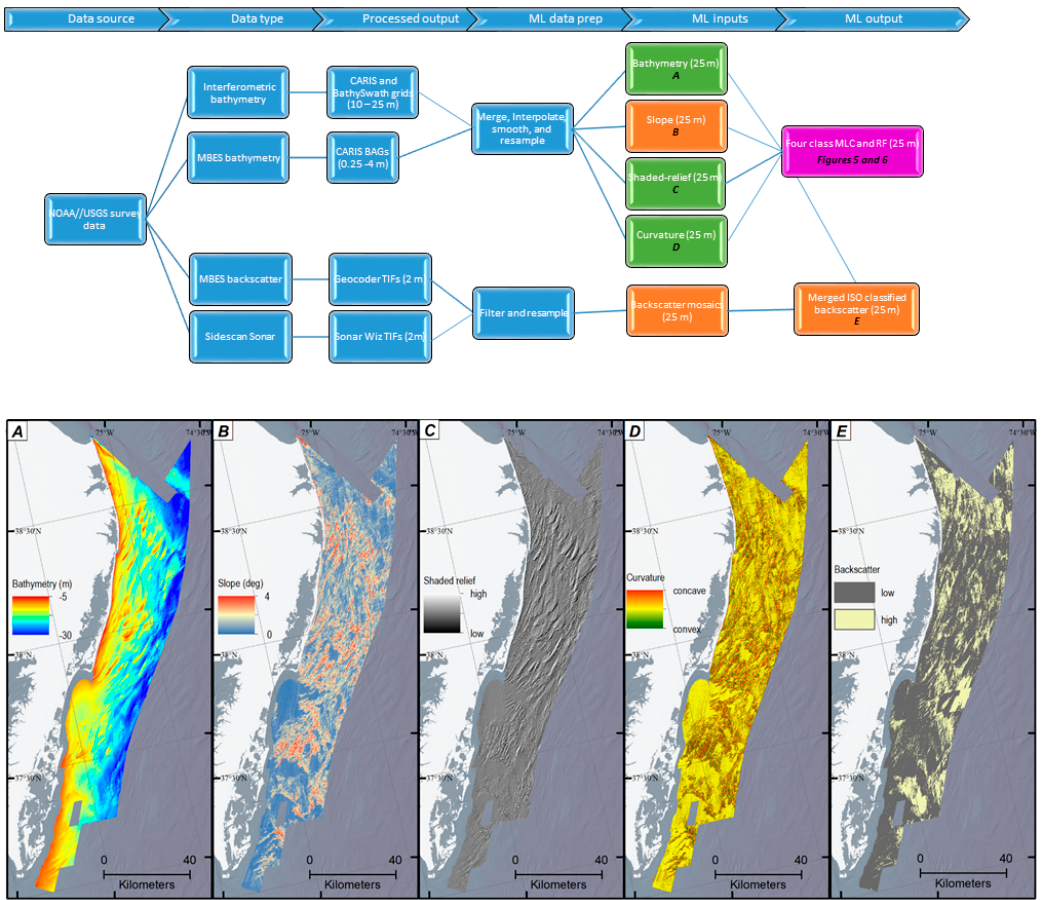
Figure 5. ( A – E ). A workflow at the top depicts the steps used to prepare the data sources for machine learning (ML). Orange and green cells in the chart represent the two and five source inputs for the iso cluster (ISO), maximum likelihood classification (MLC), and random forest (RF) classifications. Green cells were only used in the five input classifications. Orange cells were used in the two input classifications. Inputs for ML are shown in ( A ) bathymetry, ( B ) slope, ( C ) shaded-relief, ( D ) curvature, and ( E ) backscatter.